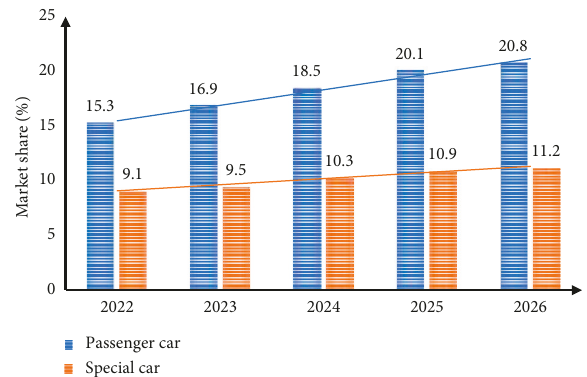
Figure 11: Market share forecast of the two types of vehicles mainly operated by the enterprise in the next five years.